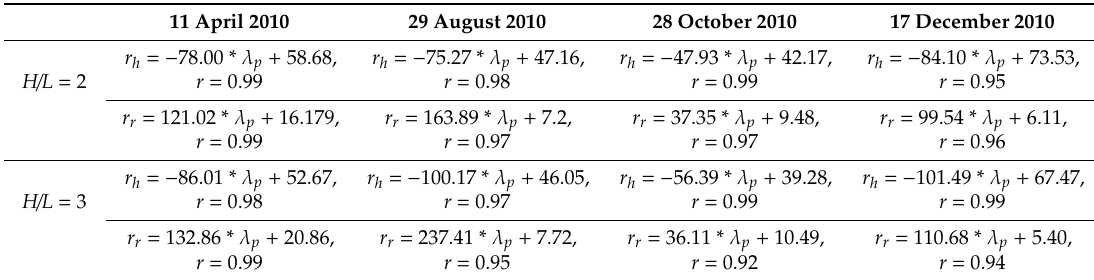
Table A1. Regressions between resistances and λ p .